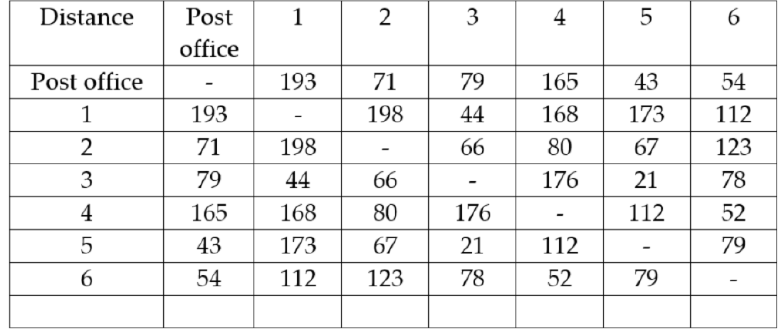
Figure 5. A distance matrix for an example of the postman delivery routing problem with six customers and two vehicles.